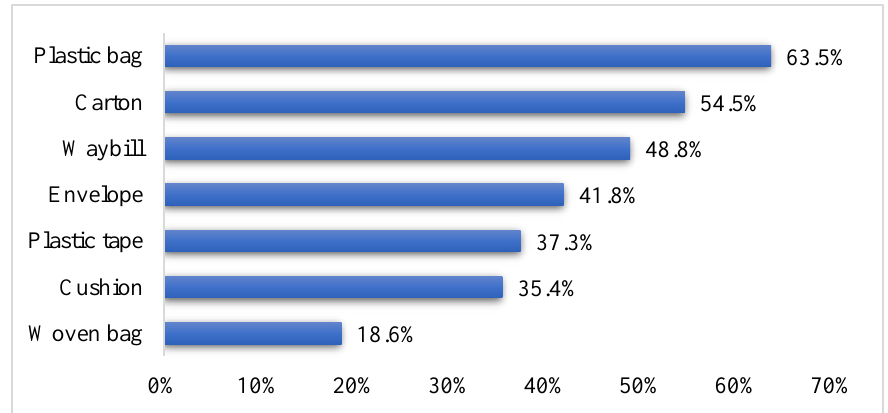
Figure 2. Ranking of seven types of express packaging discards.